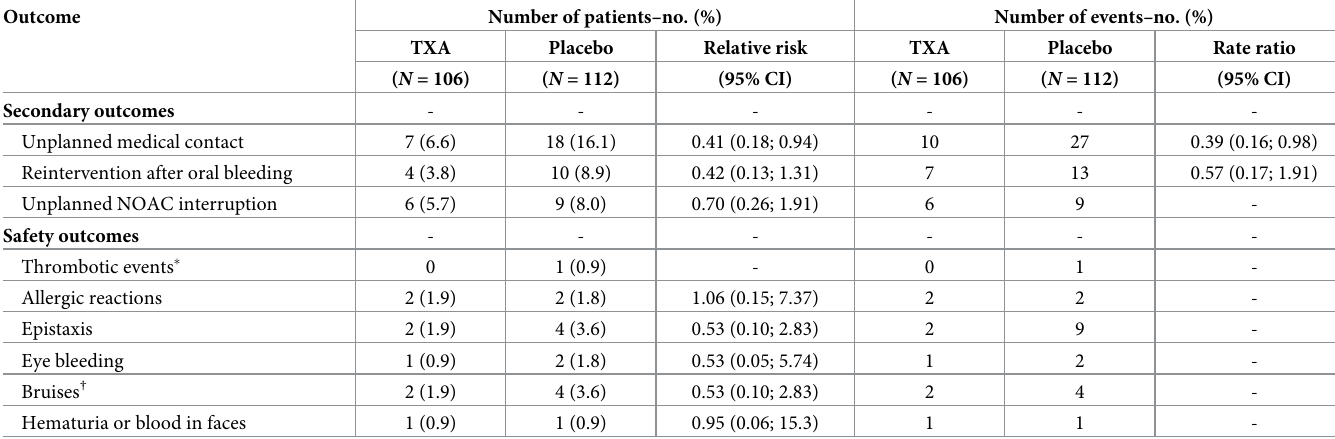
Table 3. Other secondary and safety outcomes.